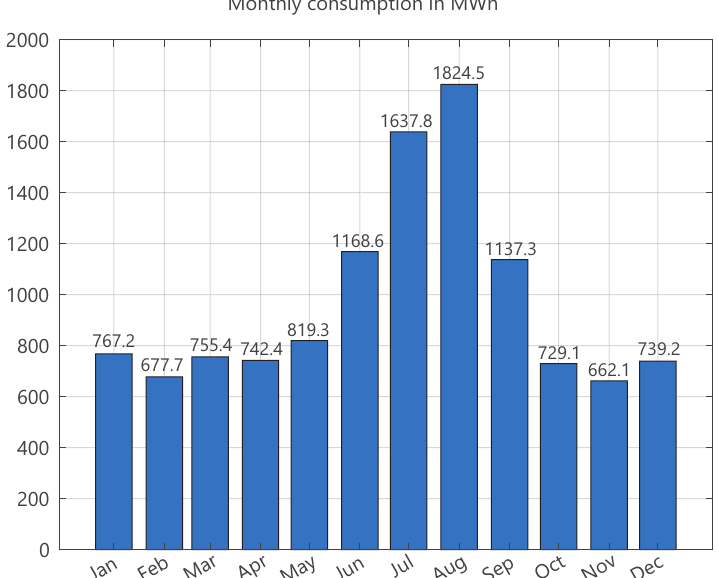
Figure 5. Monthly load values in absolute terms.